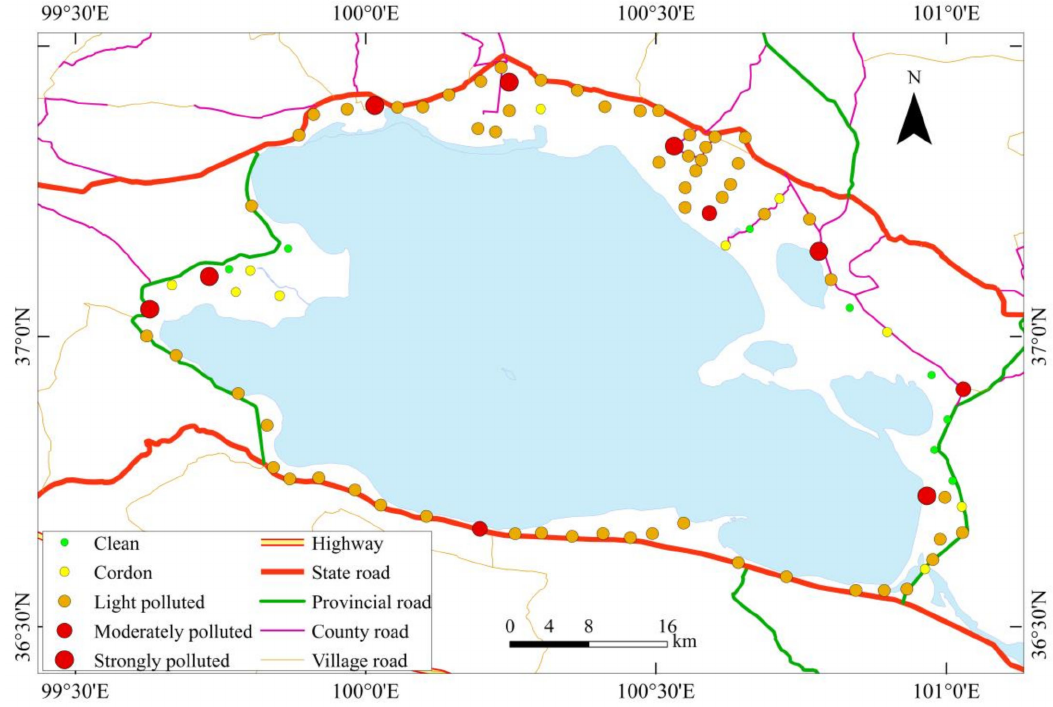
Figure 4. Spatial distribution of the Nemerow index (P n ) of heavy metals in the surface soil around Qinghai